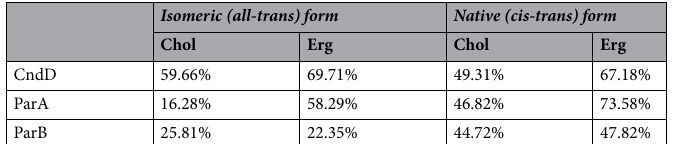
Isomeric (all-trans)